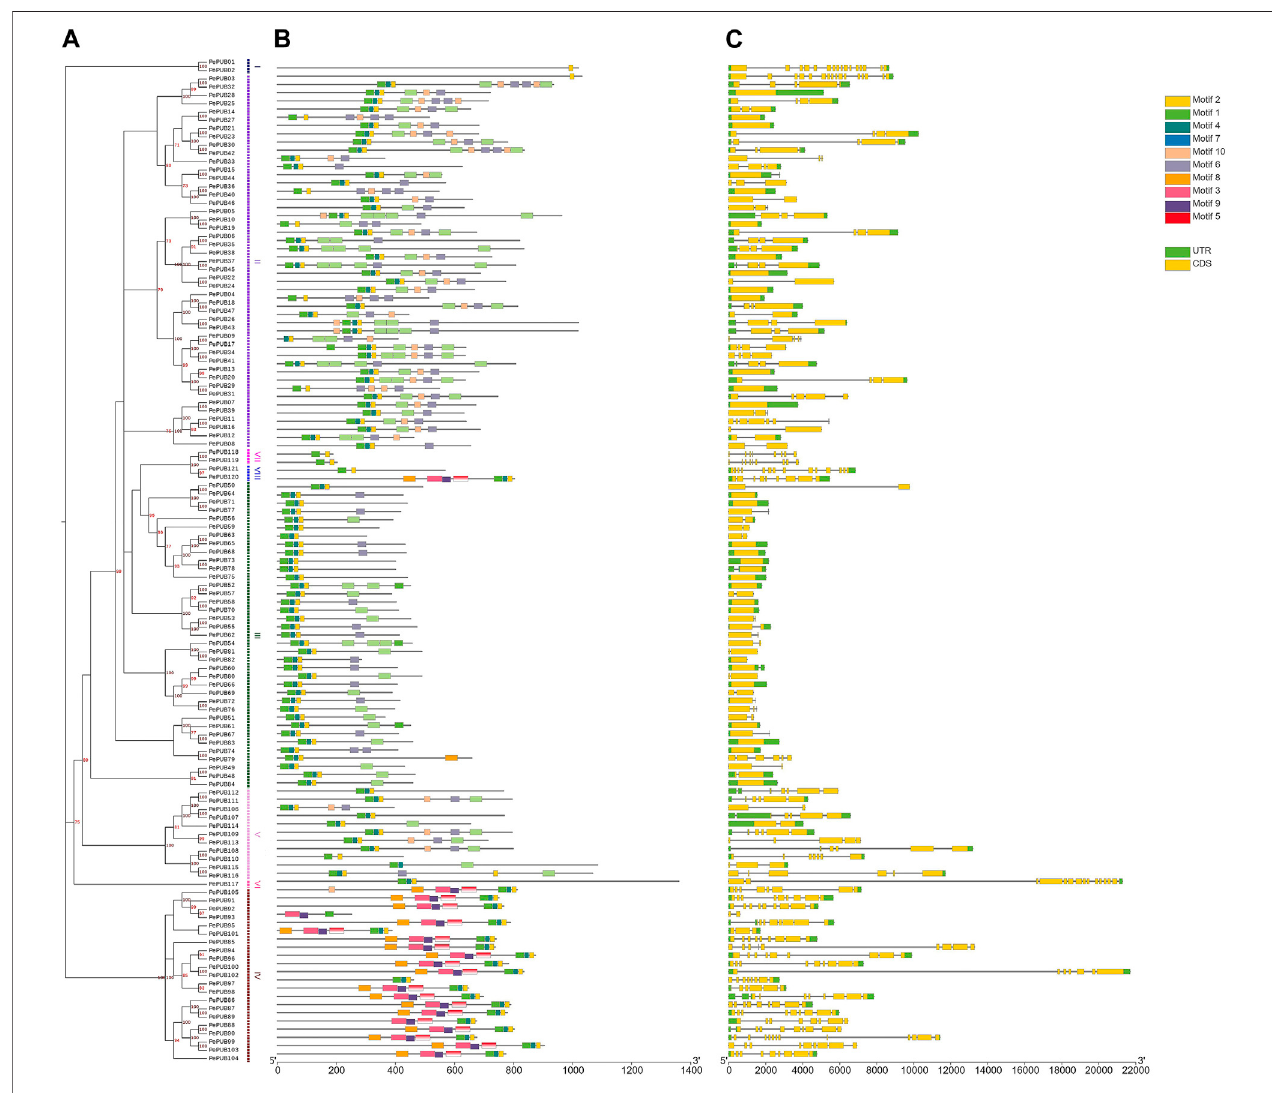
FIGURE 1 | The unrooted phylogenetic tree, motif analyses, and the gene structure of PePUB genes. (A) The neighboring tree on the left consists of 121 PePUB proteins from Phyllostachys edulis . The right side of the phylogenetic tree lists the groups. (B) The 10 conserved groups are indicated by different colored boxes. (C) Yellow indicates the untranslated 5 and 3 ′ regions, and green indicates the